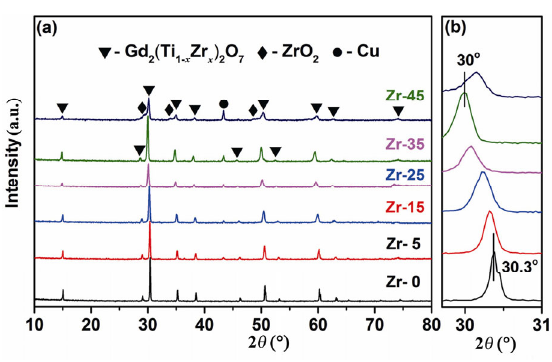
Fig. 3 (a) XRD patterns of as-prepared samples, (b)